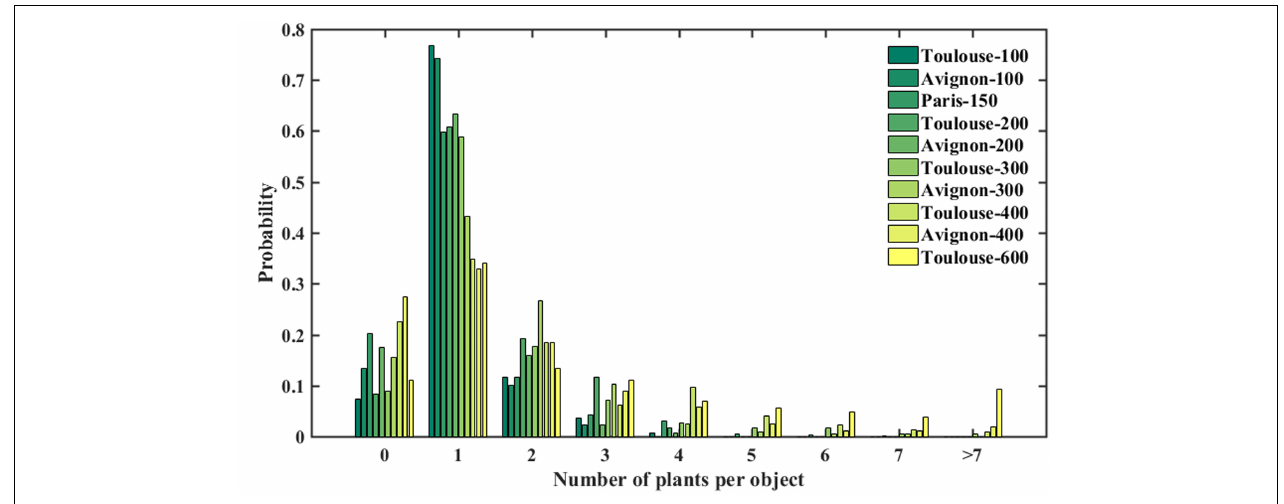
FIGURE 4 | Number of plants per object over the three